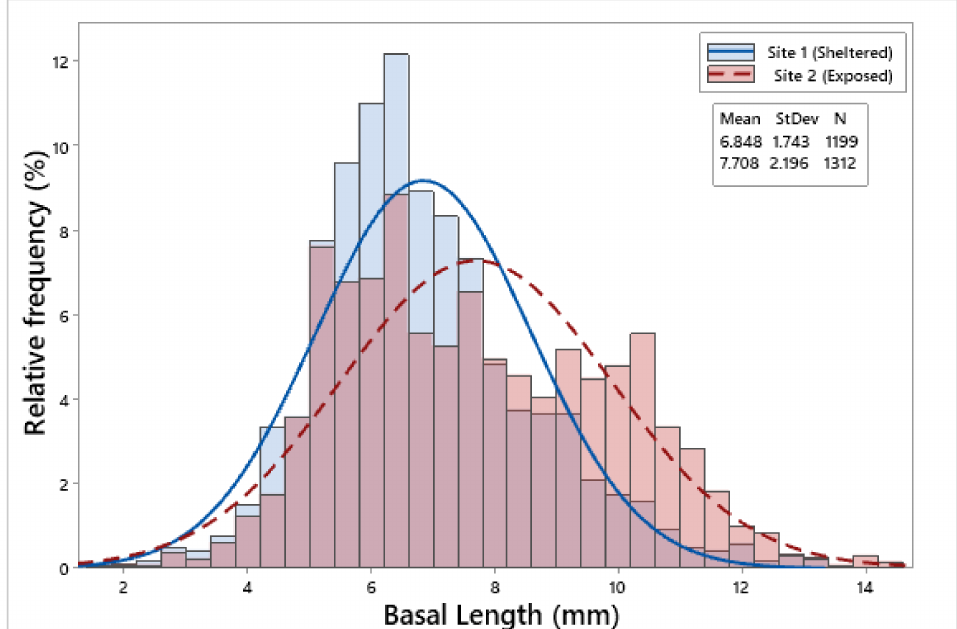
Figure 3. Basal length–frequency distribution of C. stellatus populations with overlaid fitted normal distribution at both sampling